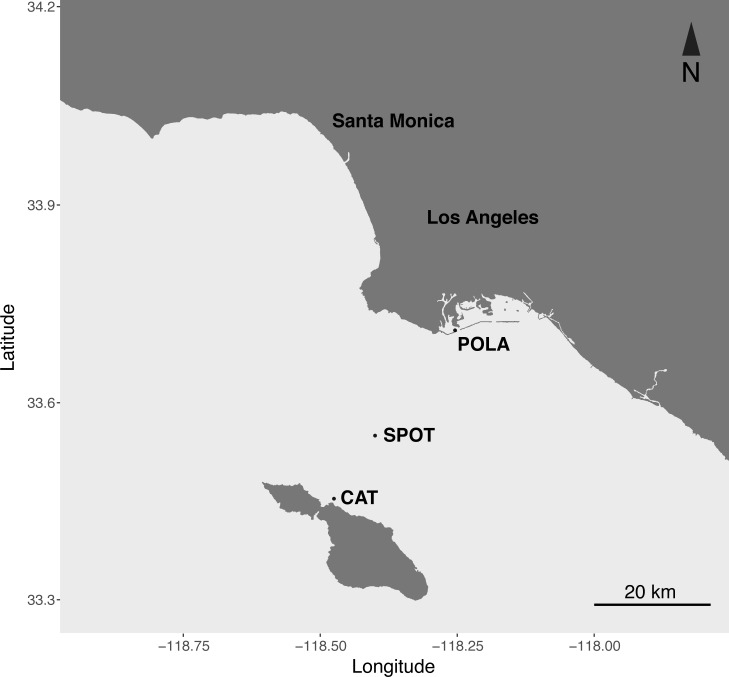
Map of the sampling sites.Port of Los Angeles (POLA, 33°42.75′N, 118°15.55′W), San Pedro Ocean Time-series (SPOT, 33°33′N, 118°24′W) and Catalina Island (CAT, 33°27.17 N, 118°28.51′W).